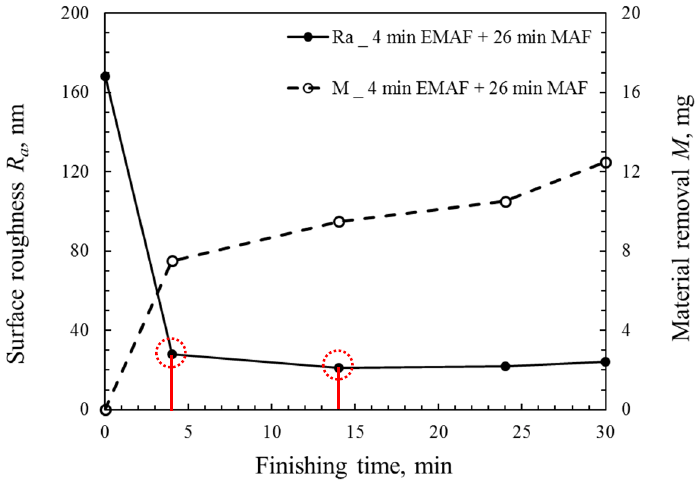
Figure 10. Change in surface roughness R a and material removal M under the condition of the combination of the 4-min EMAF step and 26-min MAF step.